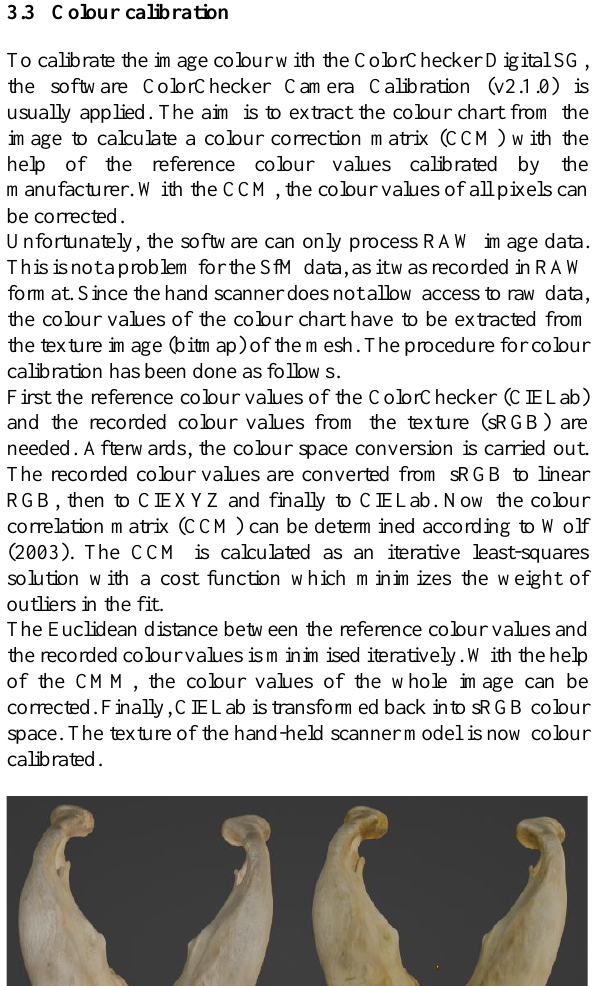
Figure 9. Textured and meshed 3D model from hand-held 3D scanner.